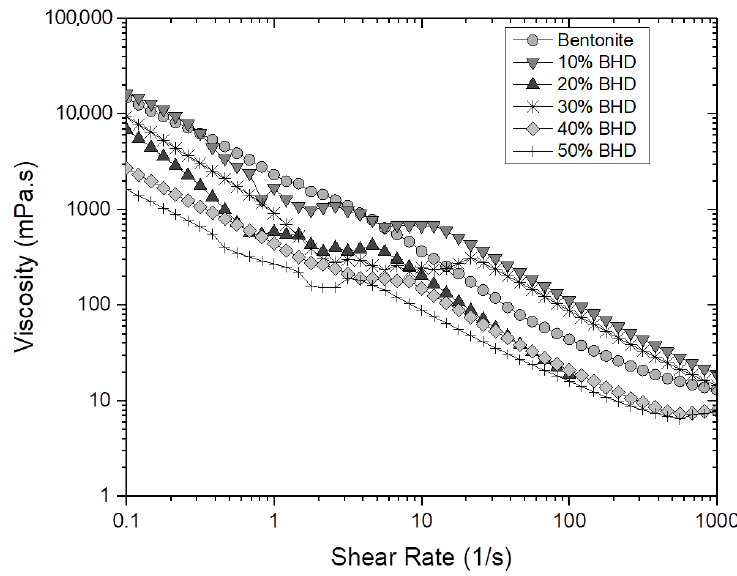
Figure 6. Flow sweep test, viscosity for different steel dust (BHD) ratios.